Question: In a single sentence, describe what this figure presents.
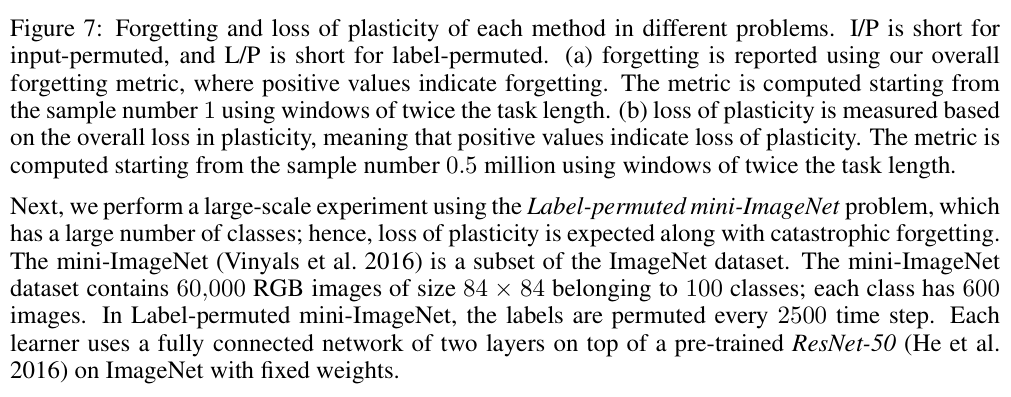
Answer: (c) exhibits the same trends manifested in the previous problem, where methods address- ing catastrophic forgetting (e.g., S-EWC) performed the best, whereas methods addressing loss of plasticity (e.g., S&P) only maintained their performance at a lower level. Fig. 7(a) and Fig. 7(b) demonstrate that both metrics of UPGD-W are among the best overall values across all problems, indicating diminished forgetting and loss of plasticity. We refer the reader to Appendix L for an ablation study on the components of UPGD.